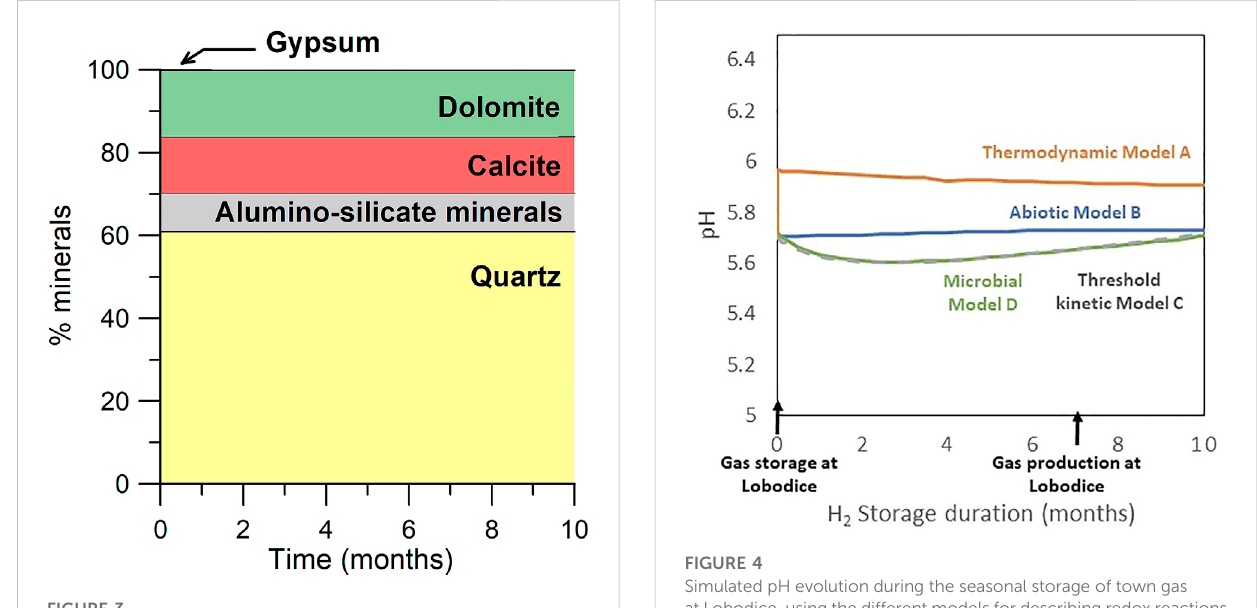
FIGURE 3 MineralevolutionsimulatedfortheLobodicereservoirduringthe seasonal storage of town gas.